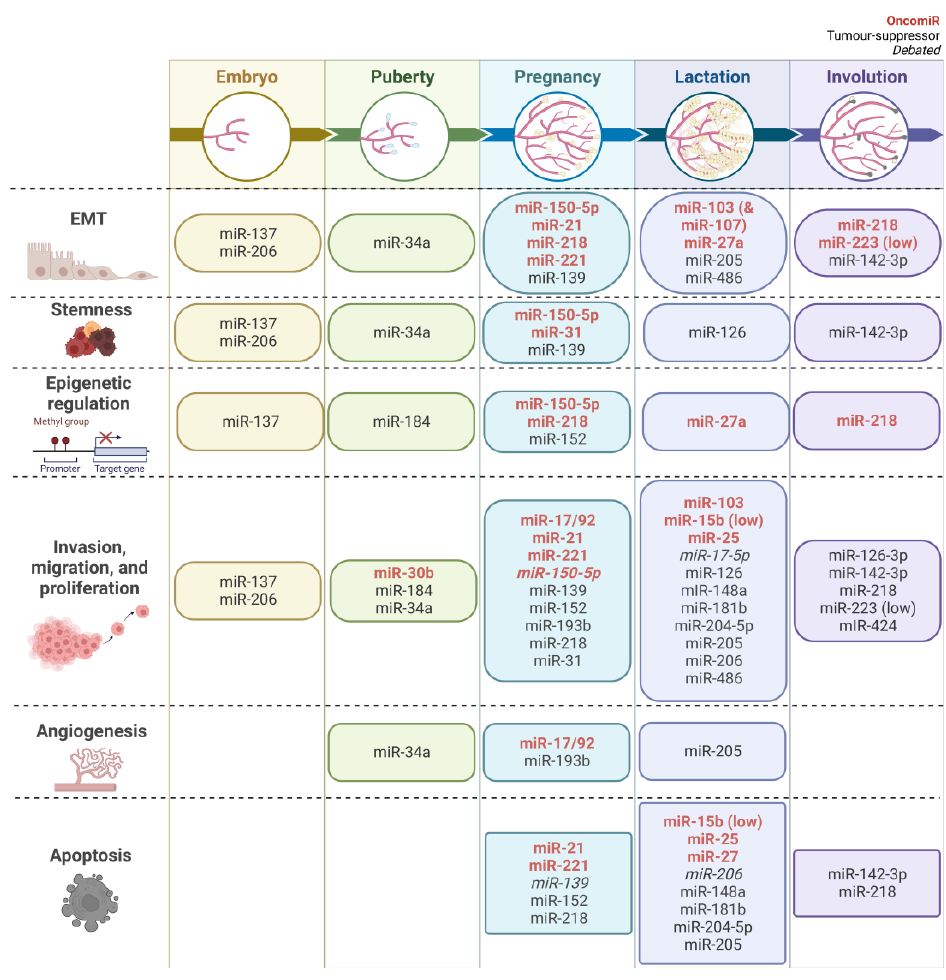
Figure 2. Breakdown of 32 microRNAs found in mammary gland development and breast cancer processes based on their association with their typical stages. Rows correspond to biological mechanisms that can be found in both processes. Columns correspond to stages of mammary gland development. MicroRNAs in red are oncogenic microRNAs. MicroRNAs in black are tumour suppressive in breast cancer. Italicized microRNAs have a debated role in breast cancer. Created with Bio- Render.com.